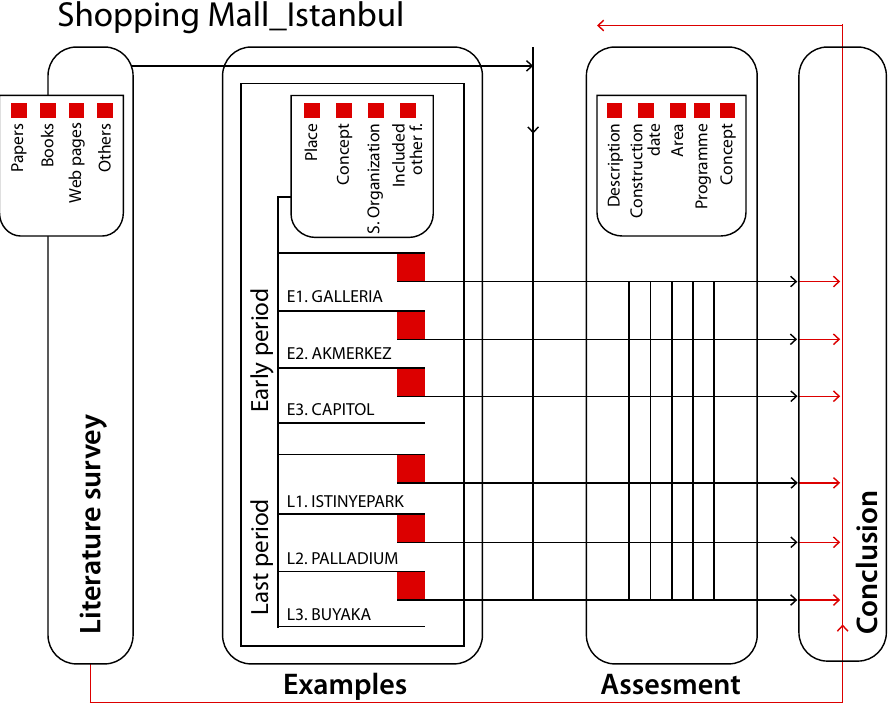
fig. 1. The method on survey. Source: